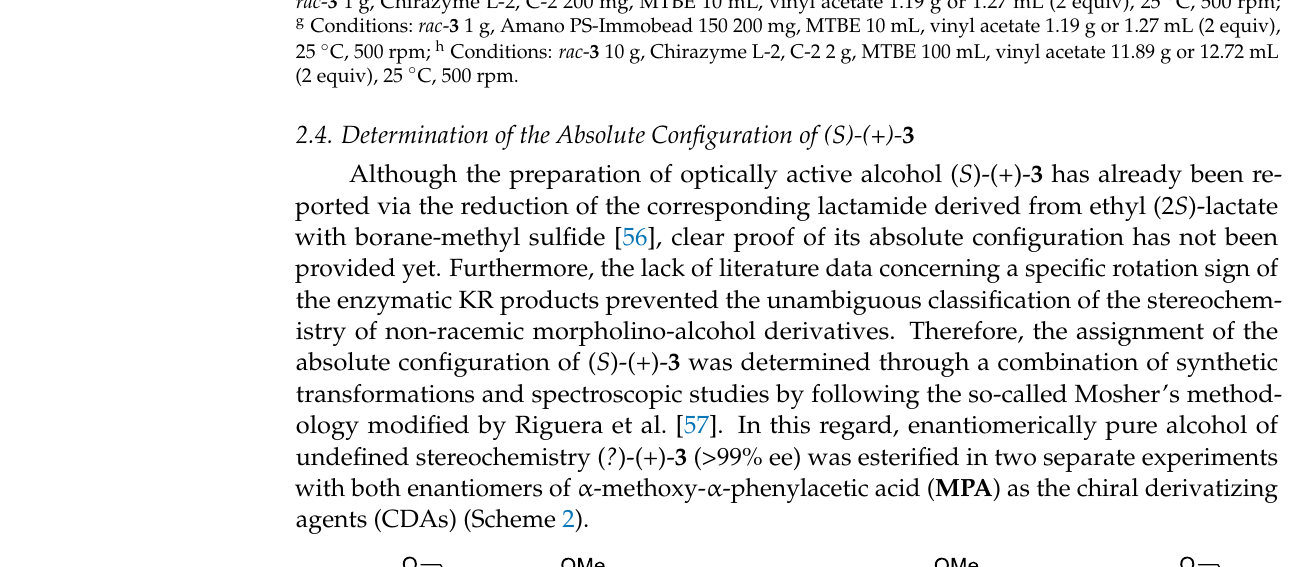
a Determined by GC analysis using a calibration curve; b Determined by HPLC analysis using a chiral sta- tionary phase; c Isolated yield after column chromatography; d Determined by chiral HPLC analysis of the corresponding alcohol ( R )-(–)- 3 obtained after NaOH-catalyzed methanolysis of ( R )-(–)- 4a ; e Calculated according to Chen et al. [45], using the equation: E = {ln[(1 − conv.)(1 − ee s )]}/{ln[(1 − conv.)(1 + ee s )]}; f Conditions: rac - 3 1 g, Chirazyme L-2, C-2 200 mg, MTBE 10 mL, vinyl acetate 1.19 g or 1.27 mL (2 equiv), 25 ◦ C, 500